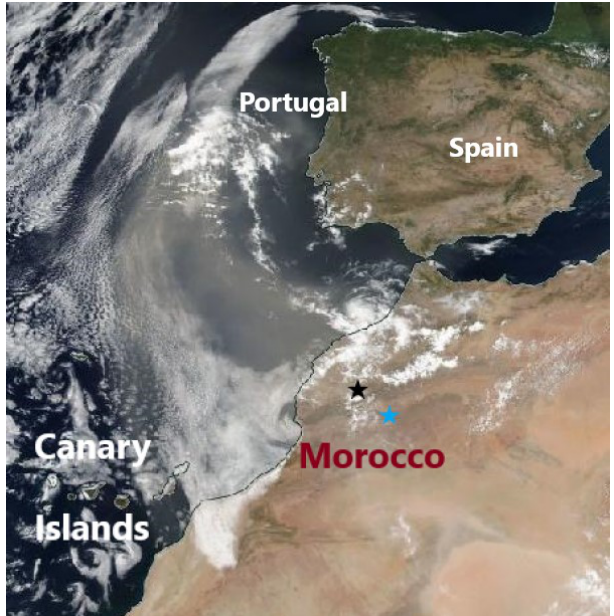
Figure 6. True colour image from MODIS/Terra visible channels on 2 August 2018 showing a dust storm travelling over the south of Morocco at 11.50 UTC. Saada and Ouarzazate AERONET sites are indicated with black and blue stars.